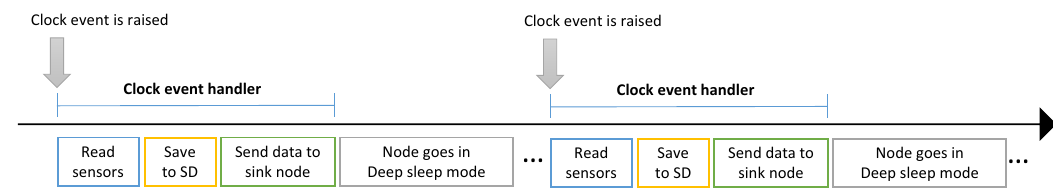
Figure 8. Event schedule of the prototype used in the